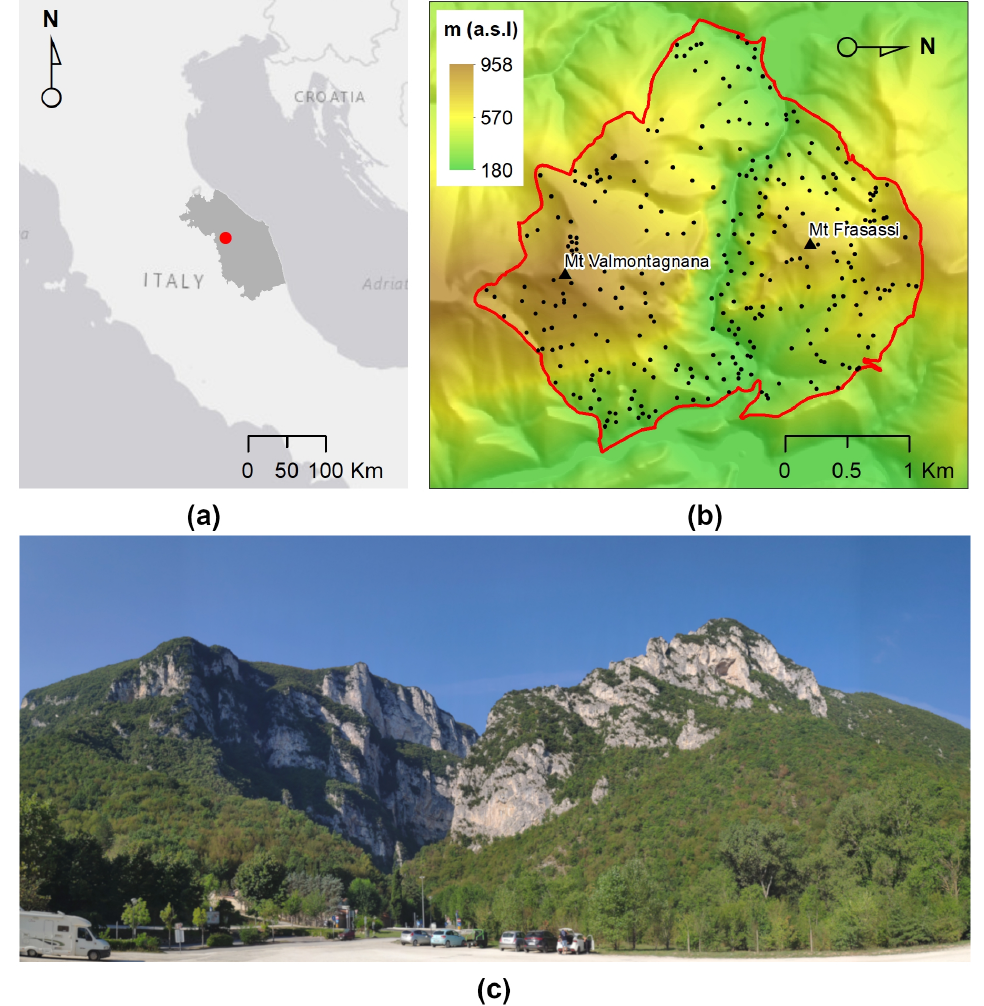
Figure 2. Study area: ( a ) Overview of study area at regional scale; ( b ) reference data of the Digital Elevation Model with the boundary of the Gola di Frasassi (Gorge of Frasassi) Special Area of Con- servation (SAC IT5320003); and ( c ) entry point to the Gorge of Frasassi. Left: Mount Valmontangana. Right: Mount